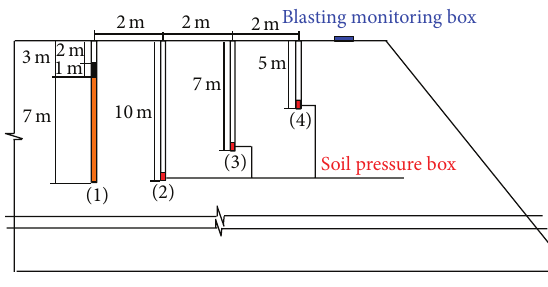
Figure 4: Arrangement of instruments and blast holes. Table 1: Parameters of explosive.